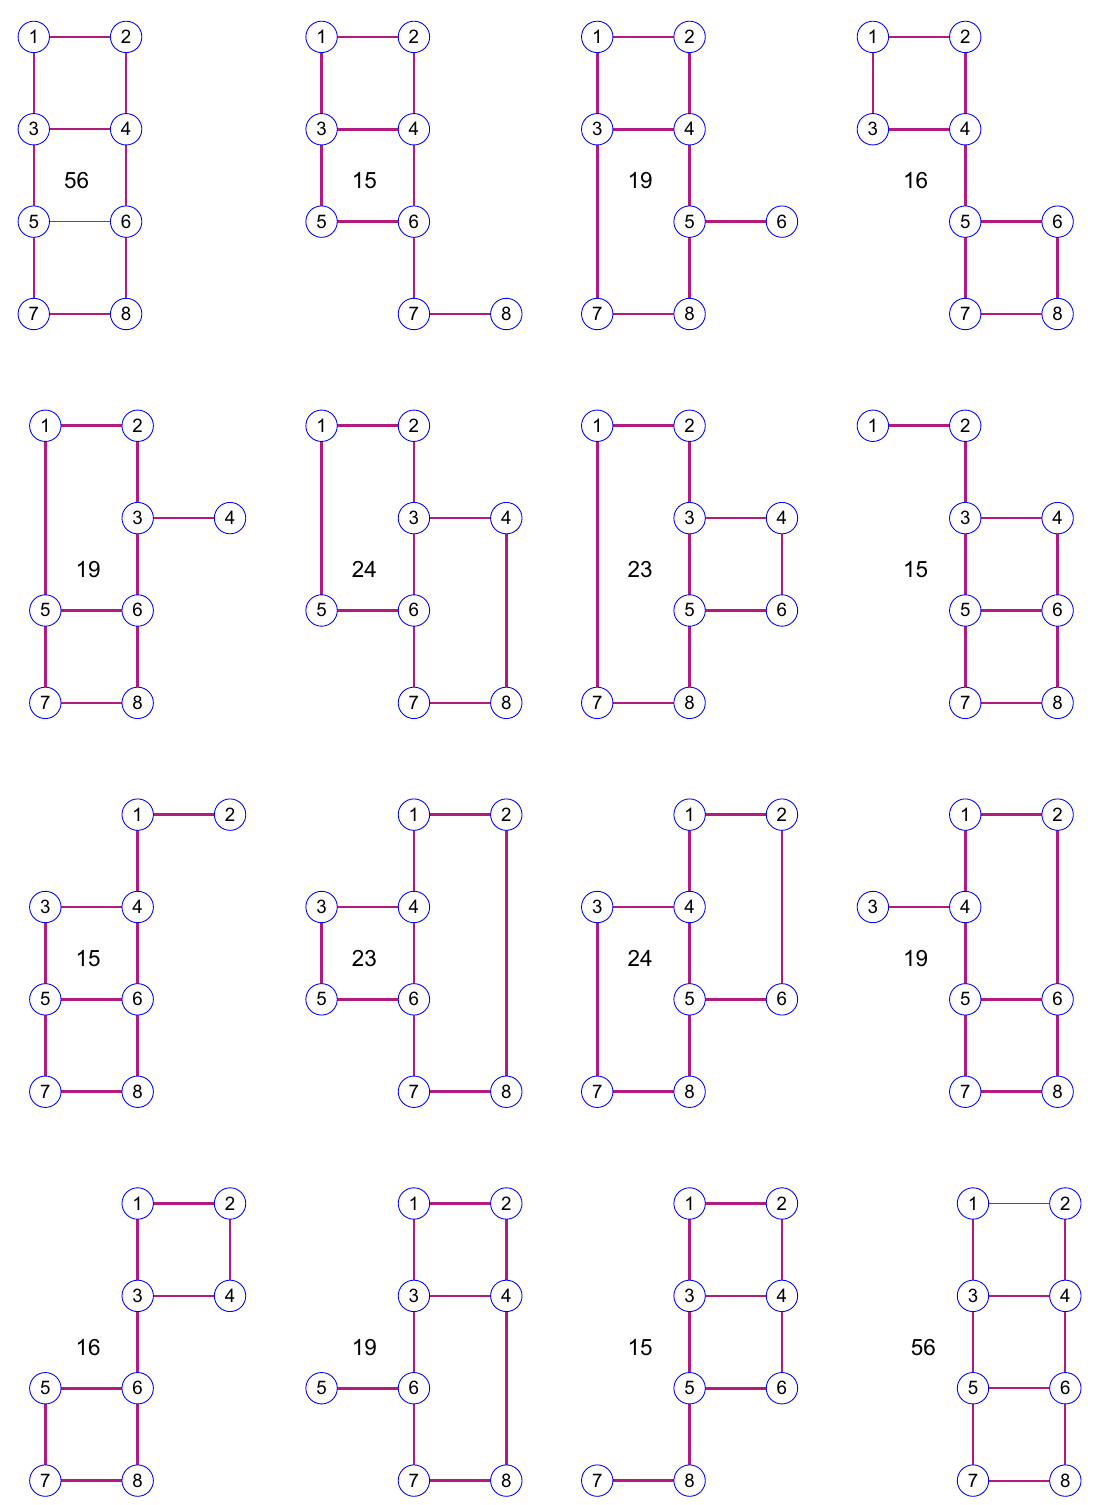
Fig. 10 Open spin chain topologies with 4 rungs. The labels of the topologies from left to right and top to bottom are {L, L, L, L}, {L, L, L, R}, {L, L, R, L}, {L, L, R, R}, {L, R, L, L}, {L, R, L, R}, {L,